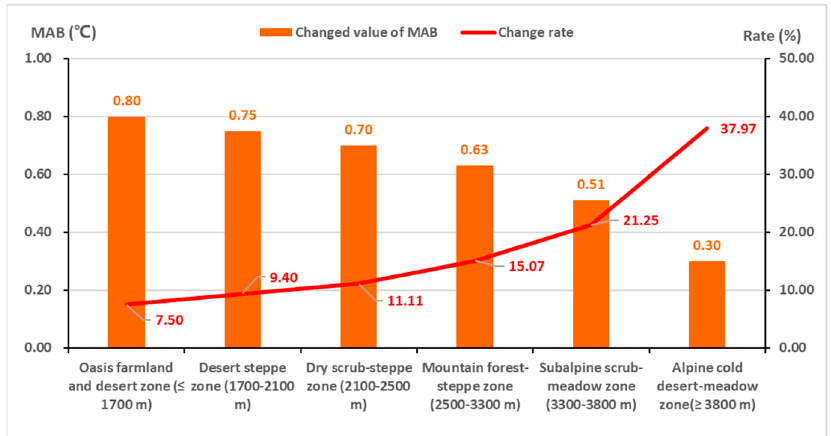
Figure 6. Change trends of MAB in the different elevation zones.